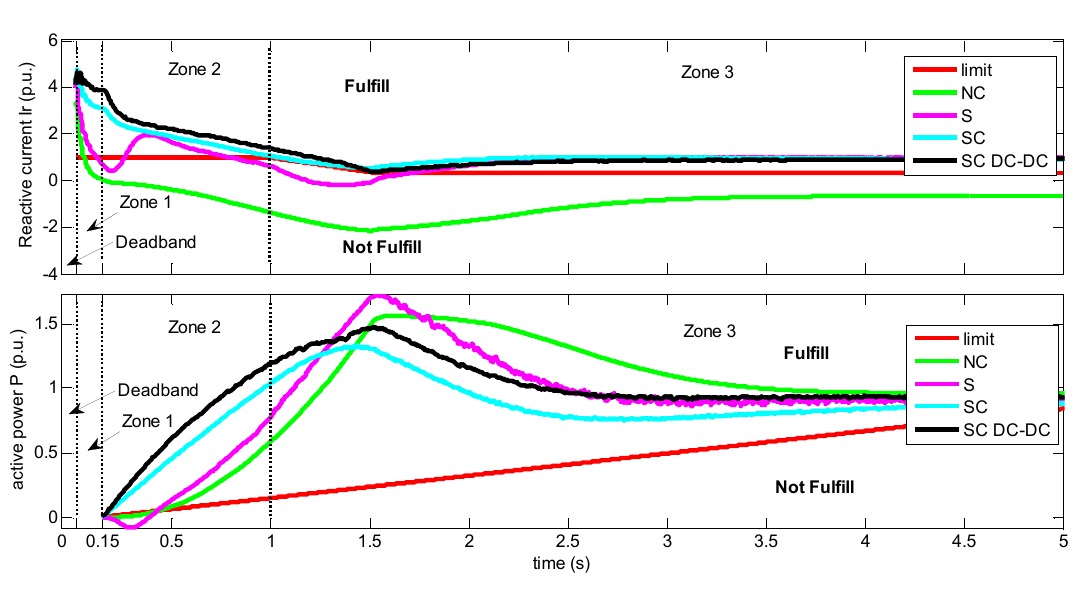
Figure 15. WTG response under German LVRT requirements. NC, results without a STATCOM; S, results with a STATCOM; SC, results with a STATCOM + ES (SC in the